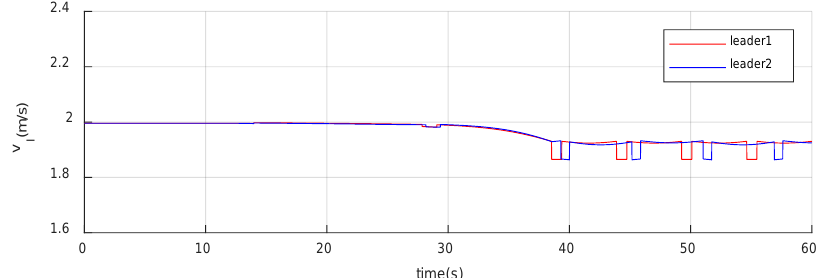
Figure 27. The variation curves of v l for the leaders during the movement.